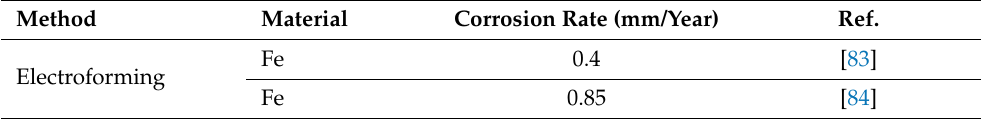
Table 6. Corrosion rates for Fe-based materials obtained by electroforming.